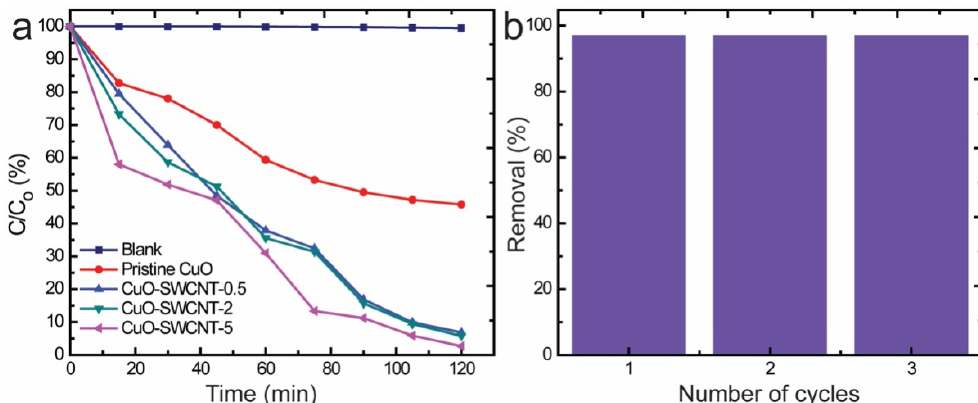
Figure 7. ( a ) Comparison of the degradation of MB by the photocatalytic action of different samples under solar irradiation; ( b ) recycling performance of the CuO-SWCNT-5 photocatalyst.